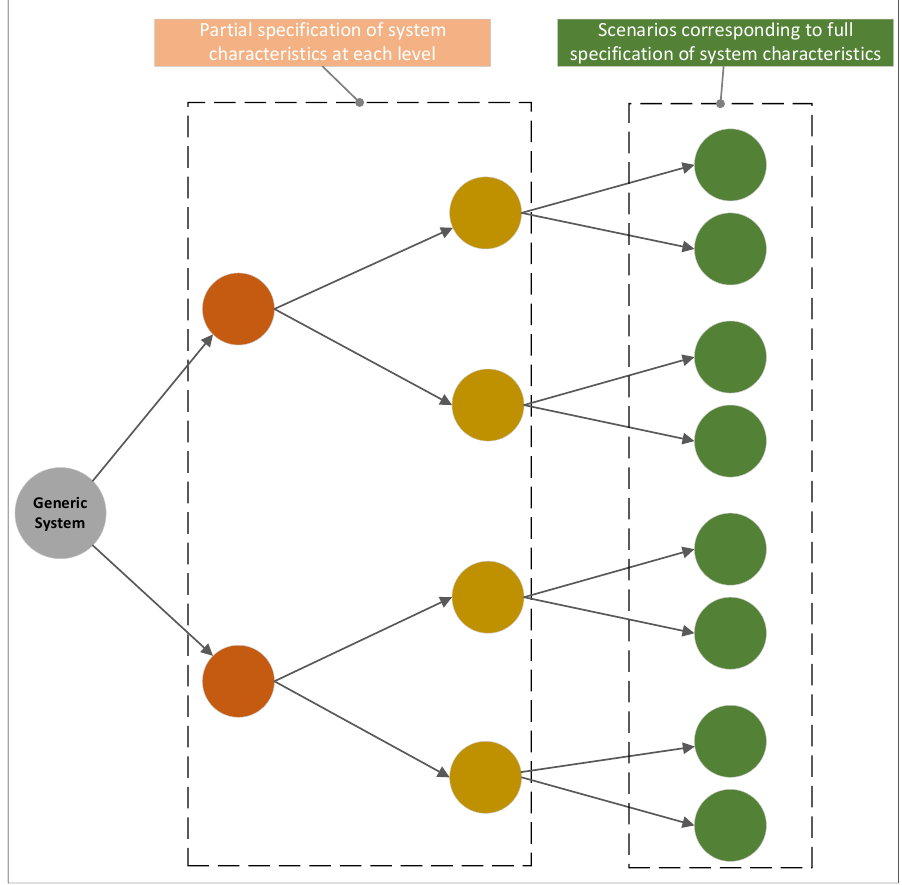
Figure 1. Generic decision tree representation .